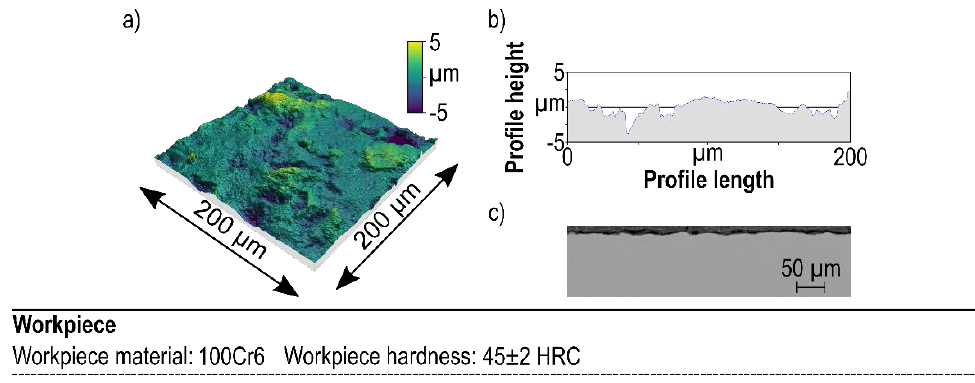
Figure 10. Sandblasted surface topography. ( a ) 3D-topography ( b ) detailed profile, and ( c ) cross section SEM picture for a coated workpiece. J. Manuf. Mater. Process. 2019 , 3 , x FOR PEER REVIEW